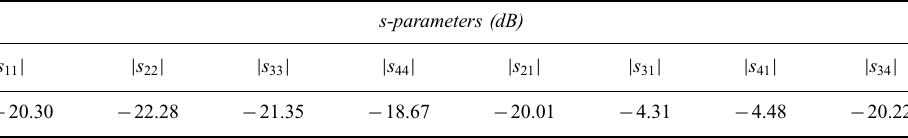
TABLE II Exact Values of All Important s-parameters of the Branch-Line Hybrid at the Desired Frequency.